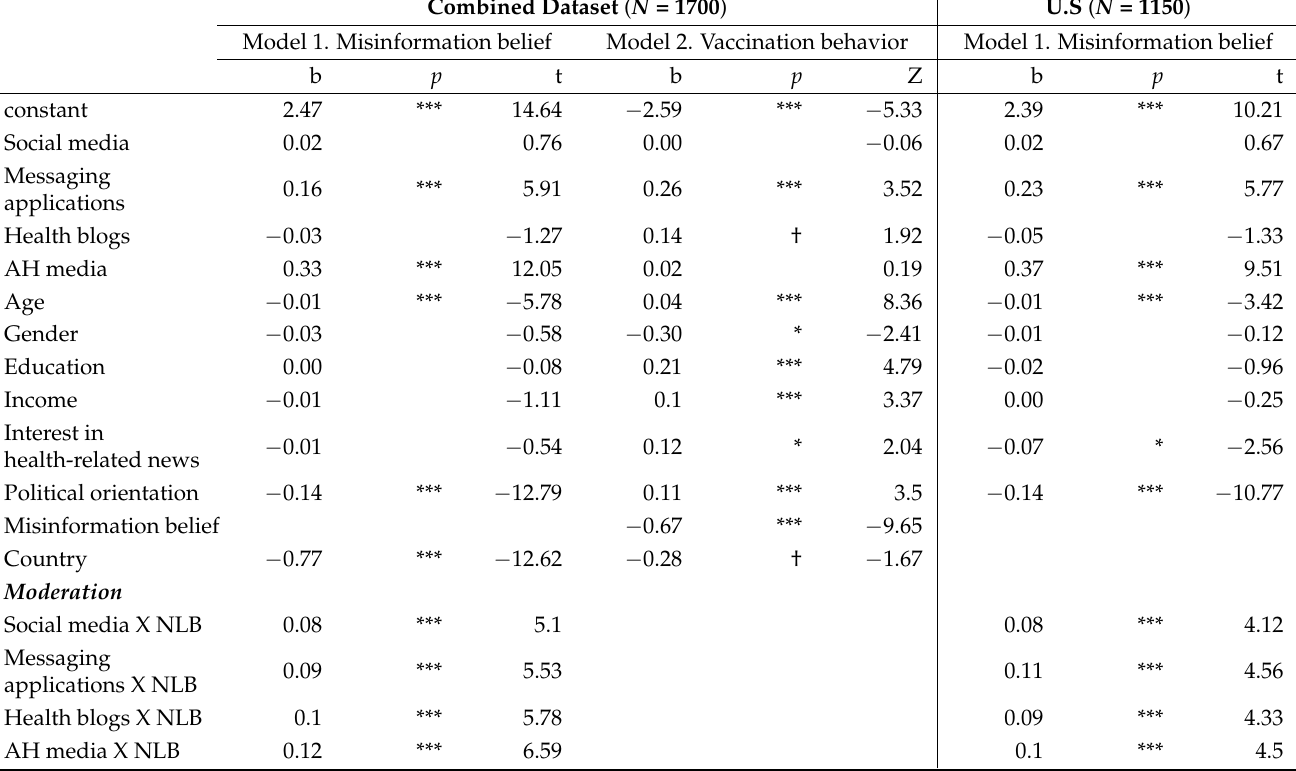
Table 3. Regression models of the main direct